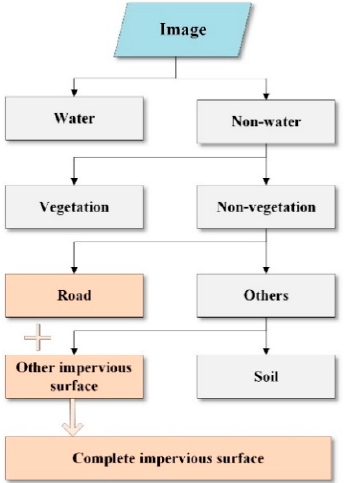
Figure 4. Classification of images through the object-oriented method (OOM). Table 2. Parameters related to segmentation.